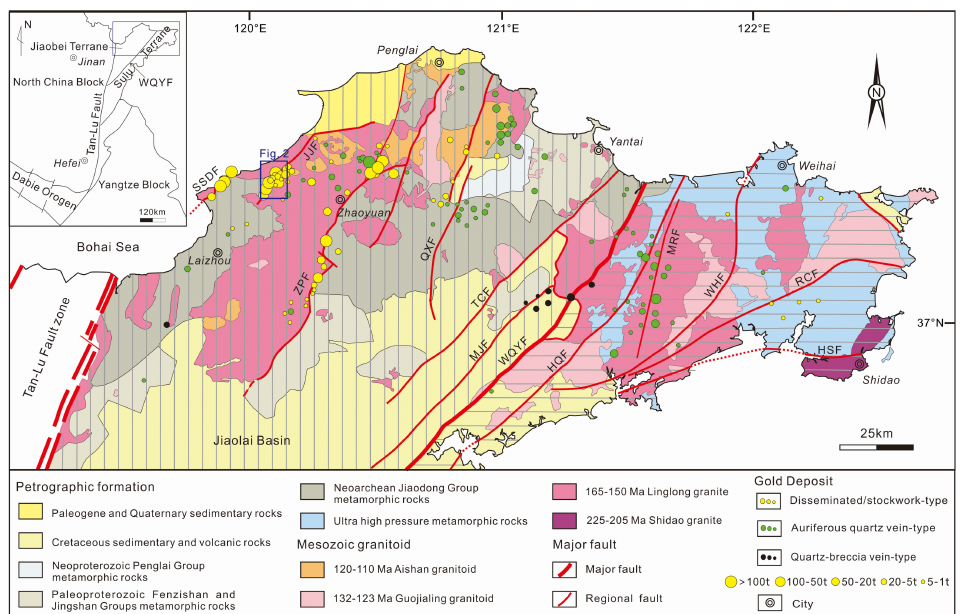
Figure 1. A simplified geological map of the Jiaodong gold province showing the distribution of major fault zones, Precambrian metamorphic rocks, Mesozoic granitoid intrusions, sedimentary rocks, and gold deposits: Modified from Yang et al. (2016) [17]. The double concentric circles represent cities. The areas covered with vertical grey lines and horizontal grey lines respectively represent Jiaobei Terrane and Sulu Terrane in Jiaodong. Abbreviations: SSDF, Sanshandao Fault; JJF, Jiaojia Fault; ZPF, Zhaoping Fault; QXF, Qixia Fault; TCF, Taocun Fault; MJF, Muping-Jimo Fault; WQYF, Wulian-Qingdao-Yantai Fault; HQF, Haiyang-Qingdao Fault; MRF, Muping-Rushan Fault; WHF, Weihai Fault; RCF, Rongcheng Fault; HSF, Haiyang-Shidao Fault.